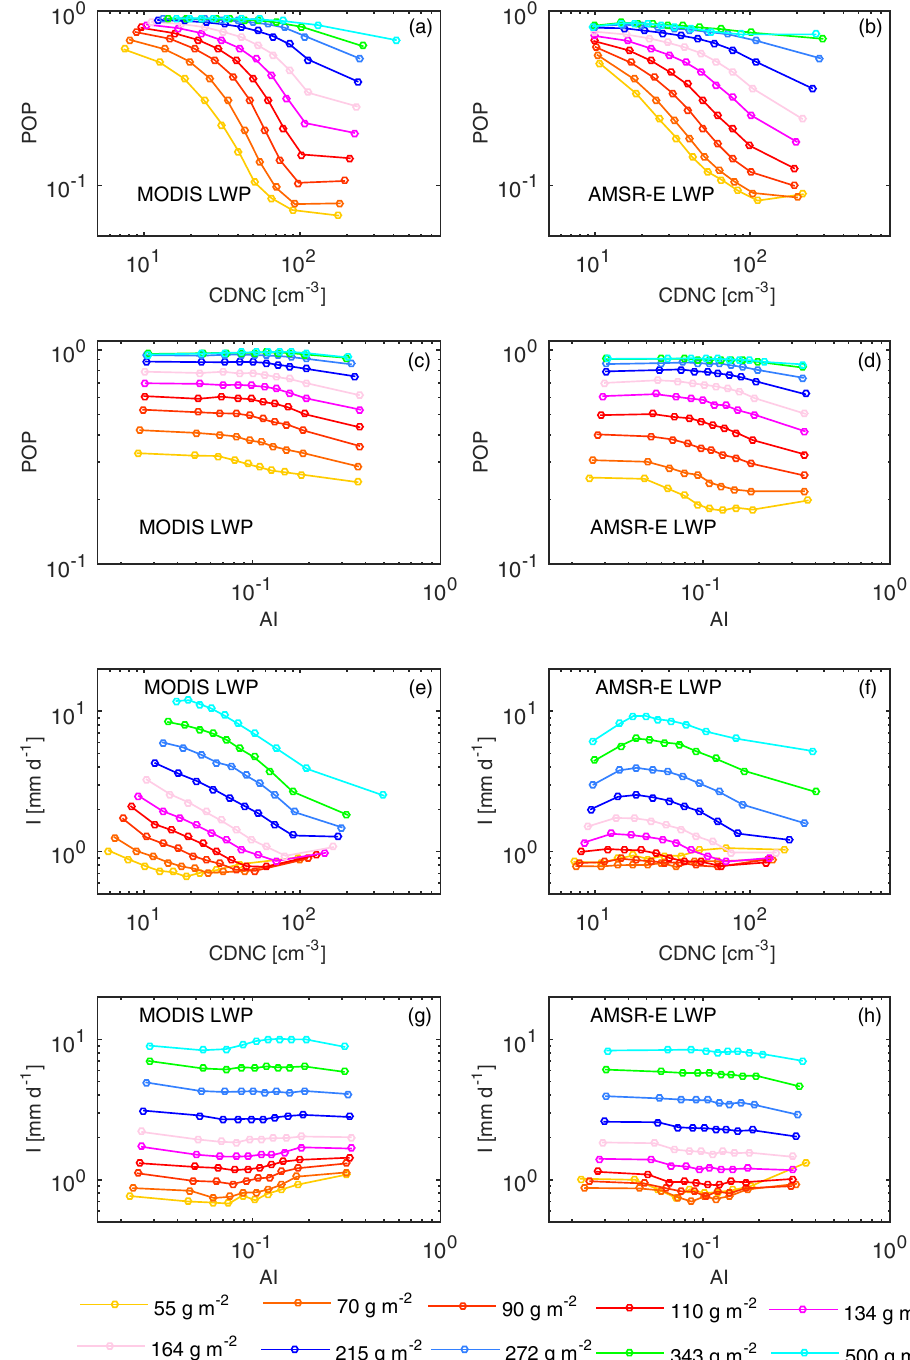
Figure 7. POP and I as a function of CDNC (AI) for each LWP bin obtained from (a, c, e, g) MODIS and (b, d, f, h) AMSR-E. The data used here are the same as those in Fig.